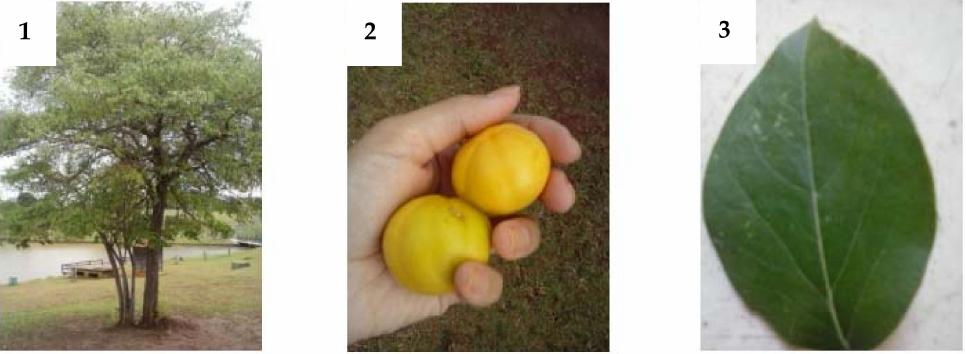
Figure 1. E. dysenterica DC. ( 1 ) tree, ( 2 ) fruit and ( 3 ) leaf. (Photos: L. F. Santana.).